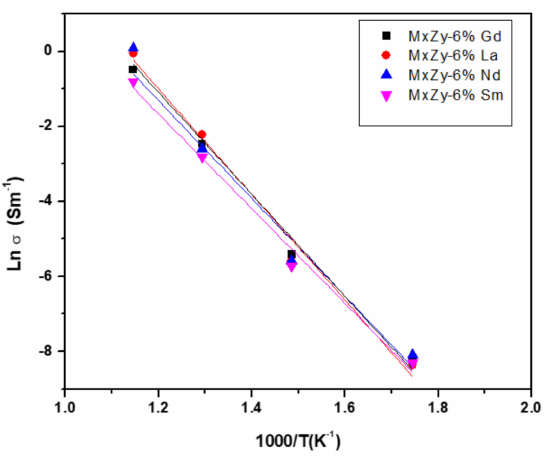
Figure 8. Arrhenius plots for ZrO 2 co-doped with 8 wt.% Y 2 O 3 and 6 wt.% Ln 2 O 3 at 600 ◦